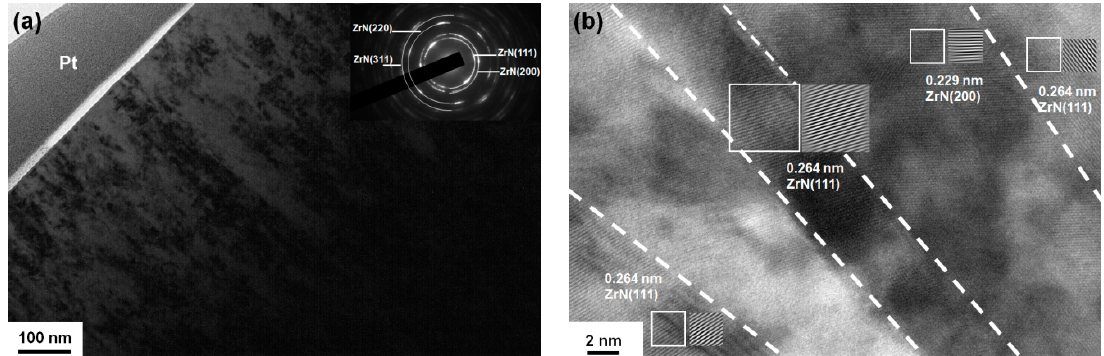
Figure 8. ( a ) Cross-sectional TEM image and SAED pattern and ( b ) high-resolution TEM image of the Zr 54.8 Si 0.3 N 44.9 films (batch